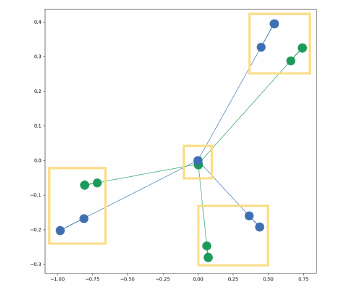
Figure 10. H in its spectral (left) and positional embedding (right).